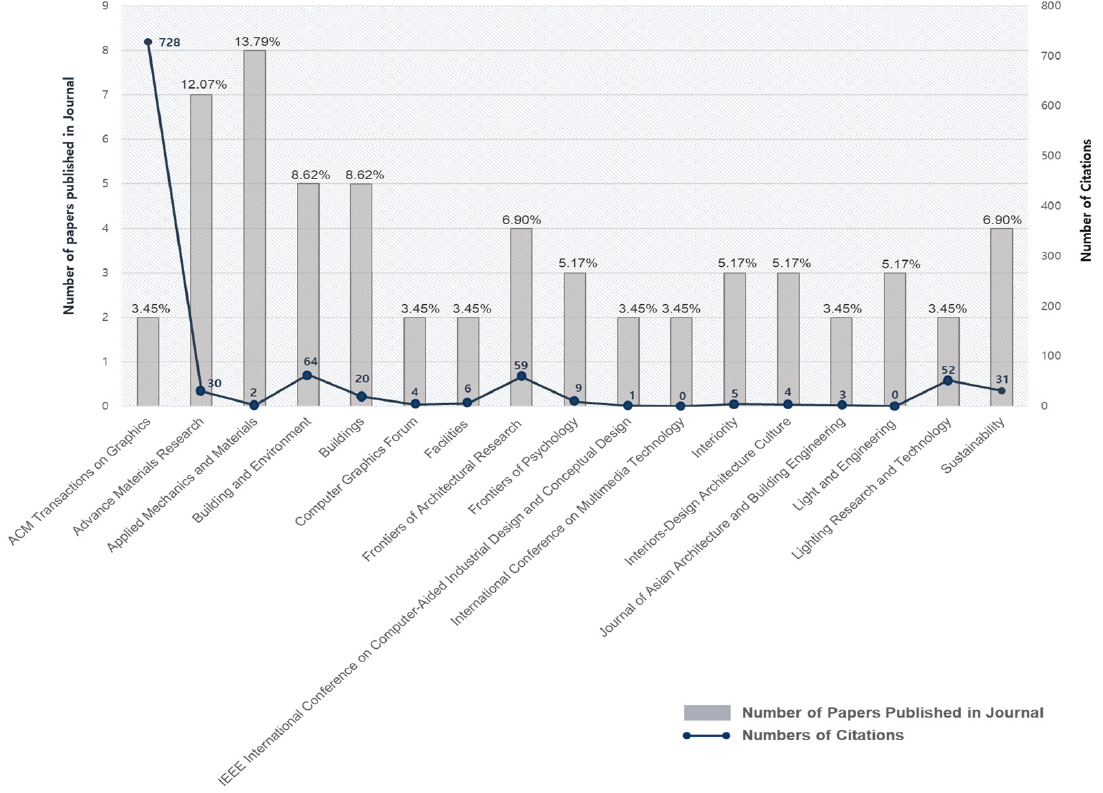
Figure 3. Number of papers published and citation of each journal.